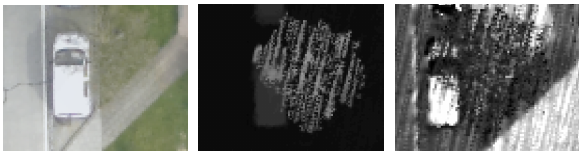
Figure 16. Misclassification of a car covered by a tree. The left image shows the car in the RGB data. In the elevation image in the middle the car is barely visible. In the intensity image on the right the front of the car is mostly covered by the tree.